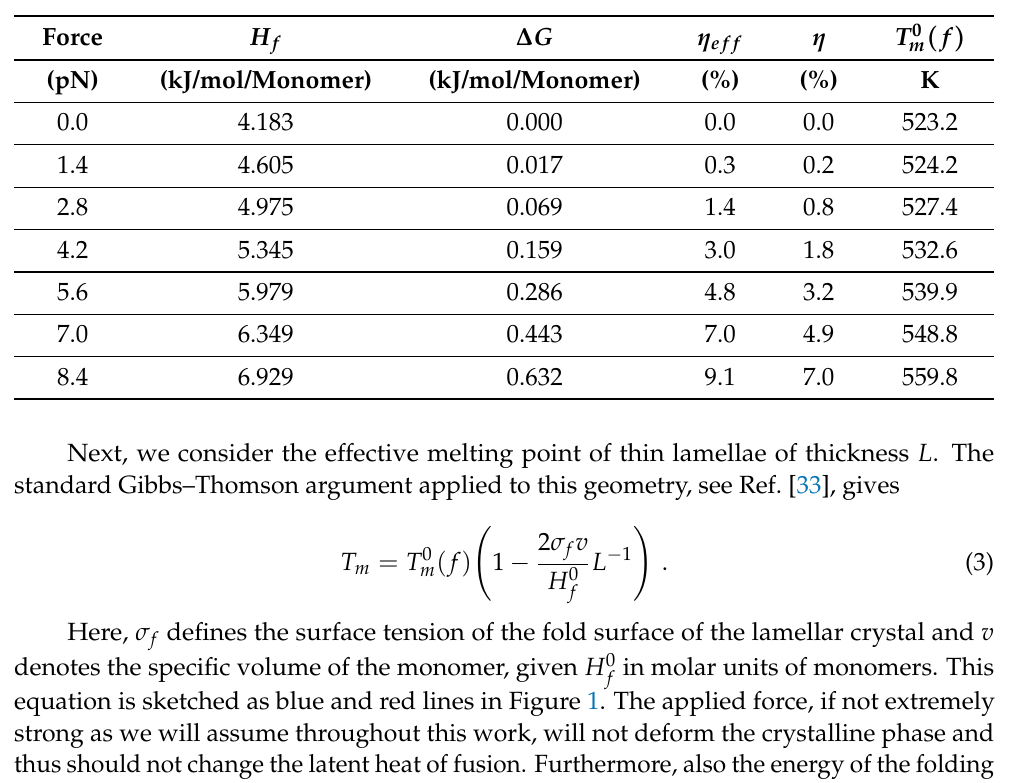
Table 1. Thermodynamic parameters for different strengths of the applied force. The ratio η is defined in Equation (2). The effective ratio is given by η ef f = ∆ G / H f . The extrapolated equilibrium melting temperature has been calculated based on Equation (1). The extrapolated equilibrium heat of = 8.945 kJ/mol, see Figure fusion is given by H 0 f